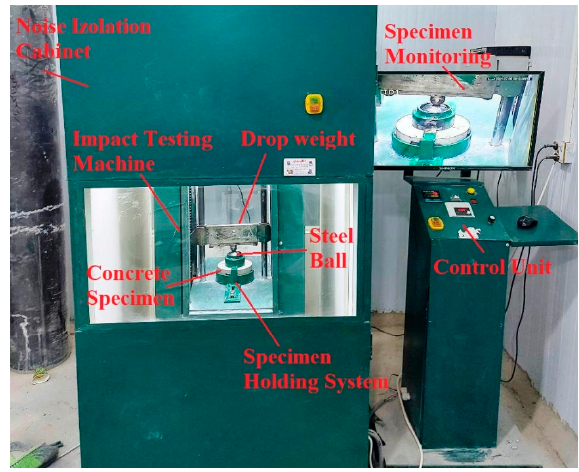
Figure 3. The repeated impact testing machine.